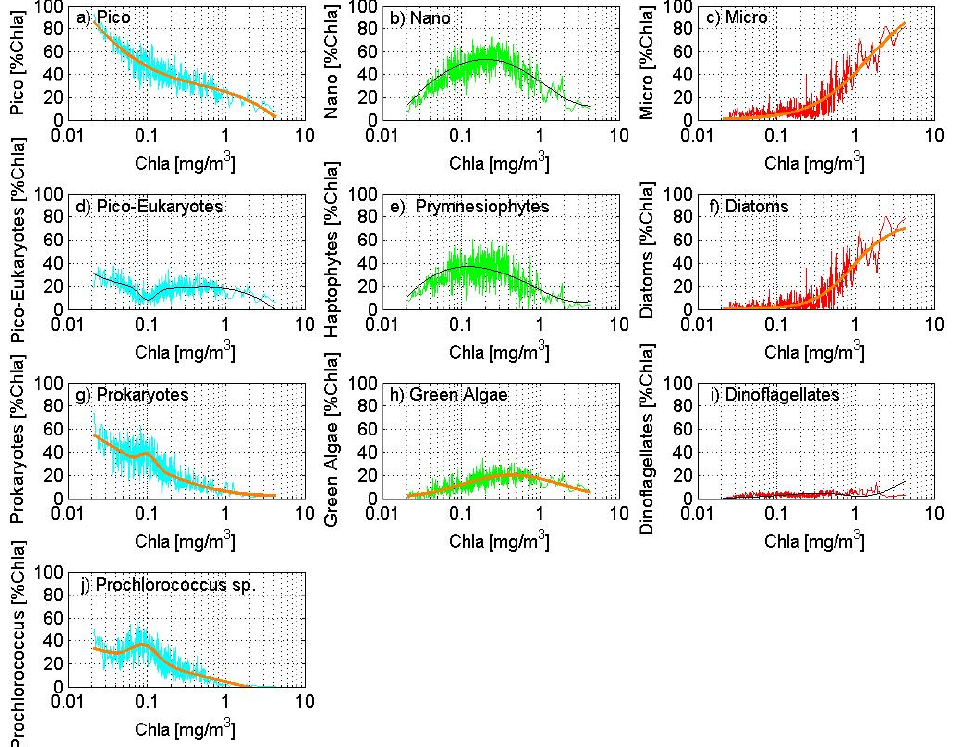
Fig. 2. Global relationships between Chl- a and %Chl- a of each PFT; (a) Picoplankton, (b) Nanoplankton, (c) Microplank- ton, (d) Pico-eukaryotes, (e) Prymnesiophytes (Haptophyotes), (f) Diatoms, (g) Prokaryotes, (h) Green algae, (i) Dinoflag- ellates, (j) Prochlorococcus sp. The orange thick curves are the least-square fits to the original data (a, c, f, g, h, j) , whereas the black thin curves are the fits indirectly derived from the least square fits ( b, d, i ; e.g. 100 × Nano